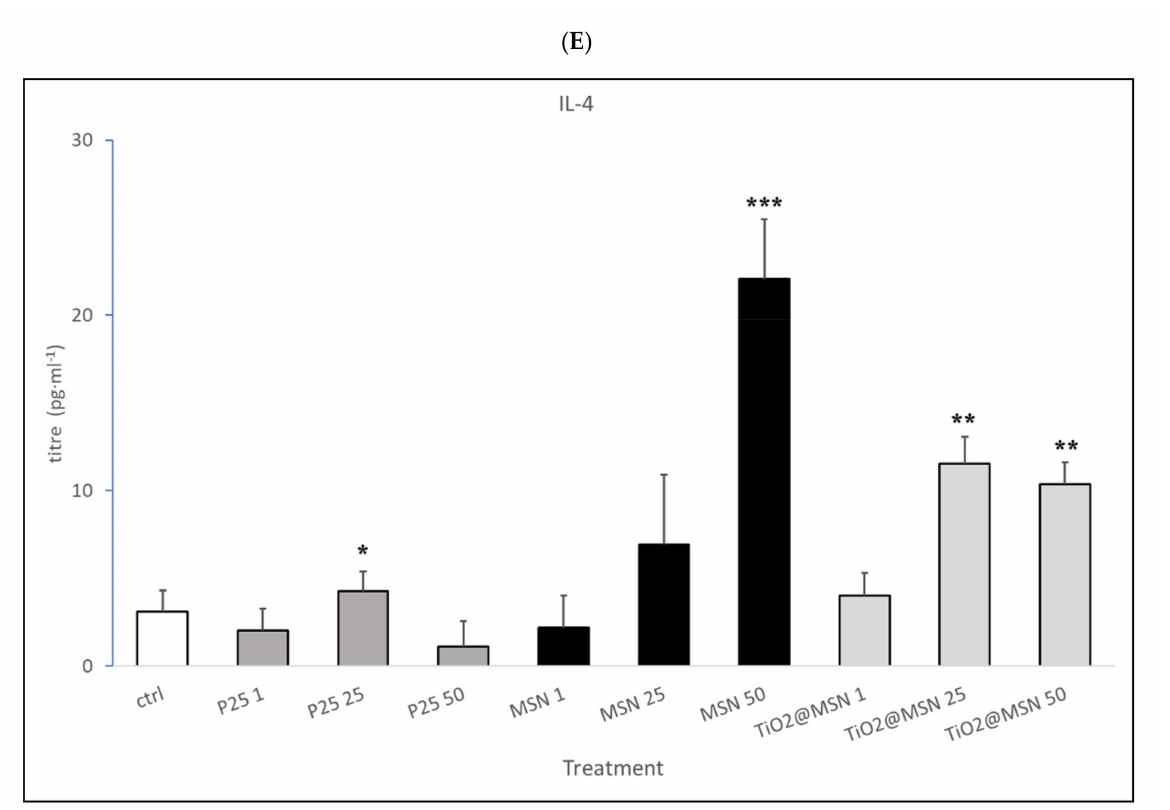
Figure 8. Secreted cytokines pattern: titer of ( A ) IL-2; ( B ) INF- γ ; ( C ) IL-1 β ; ( D ) IL-10; ( E ) IL-4. Significance values: * p < 0.05, ** p < 0.005, *** p < 0.0005; error bars represent the standard error of the